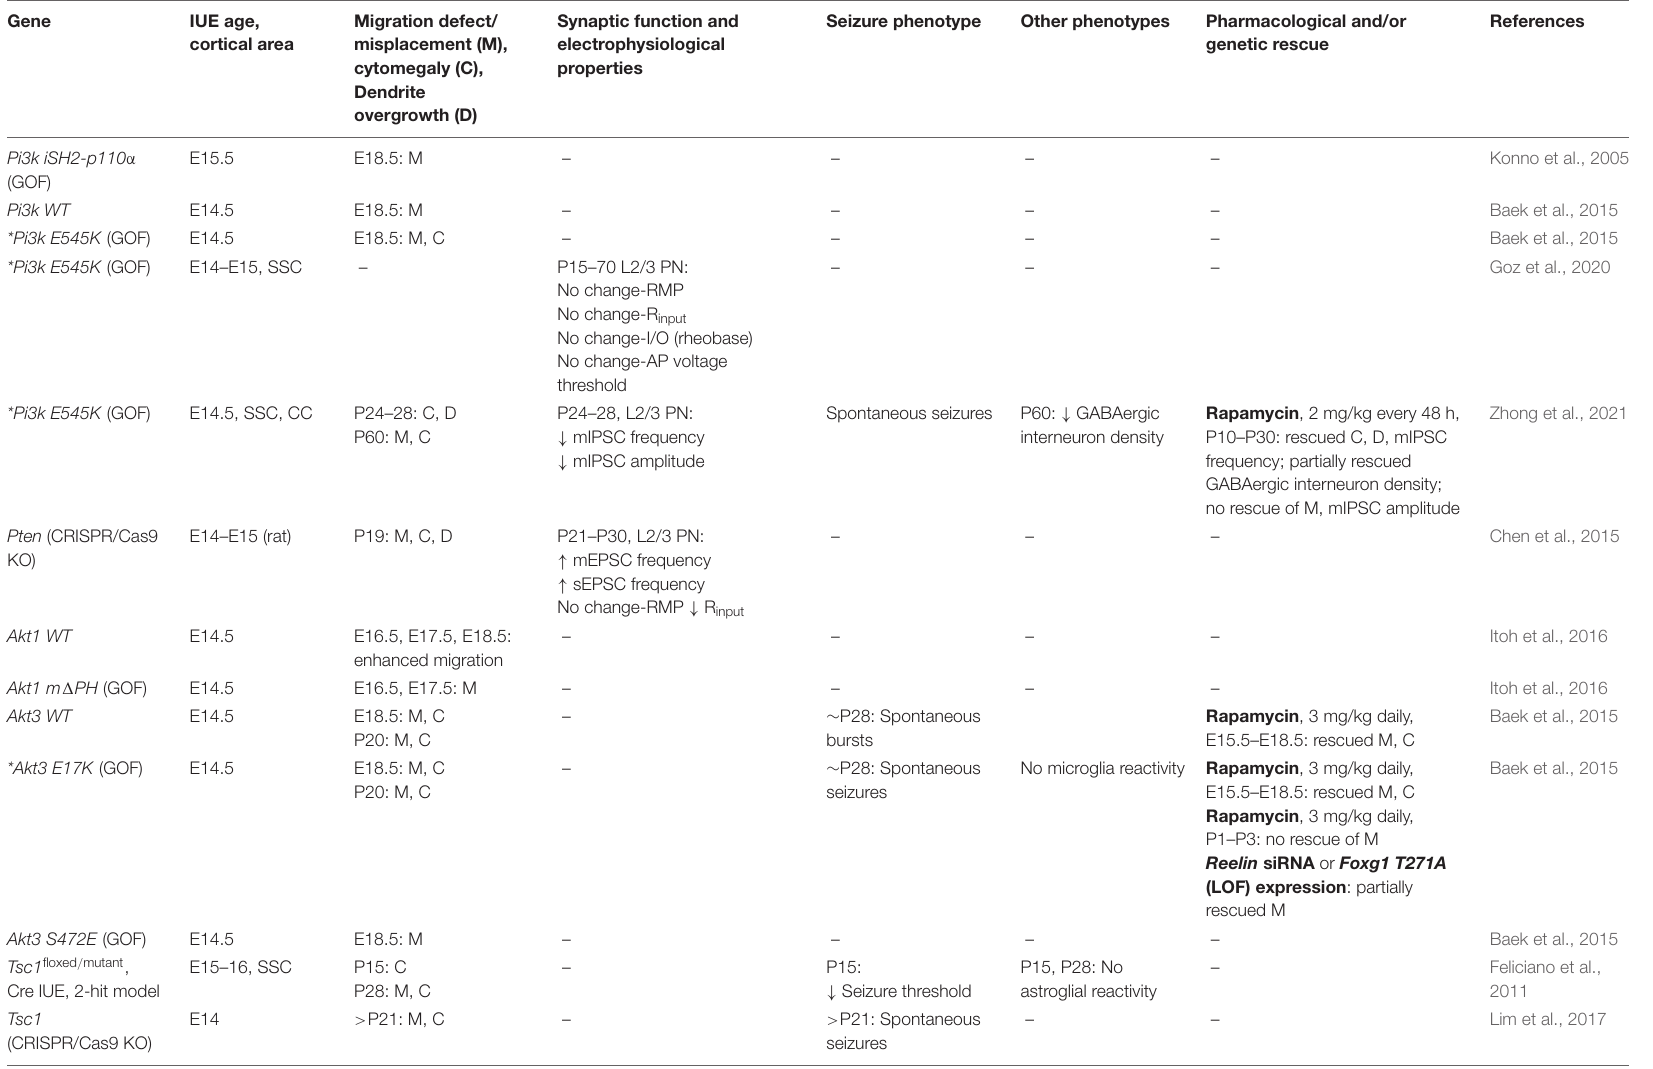
TABLE 1 | Summary of IUE-based rodent models of mTORopathies.